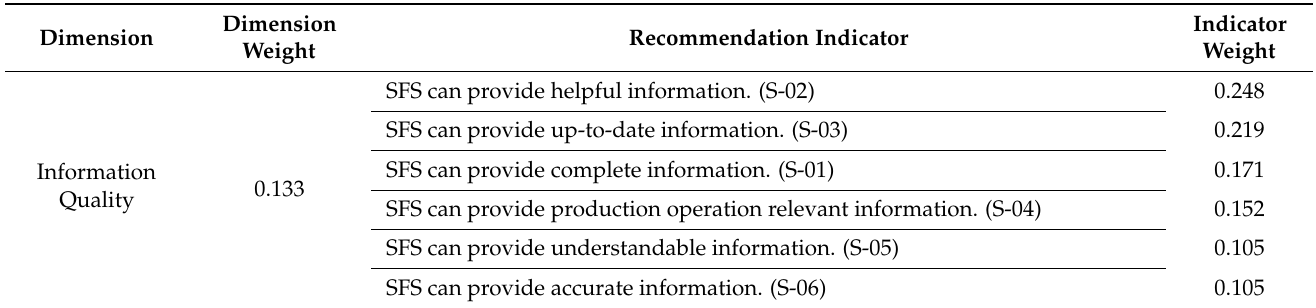
Table 7. The sorting of all the recommendation